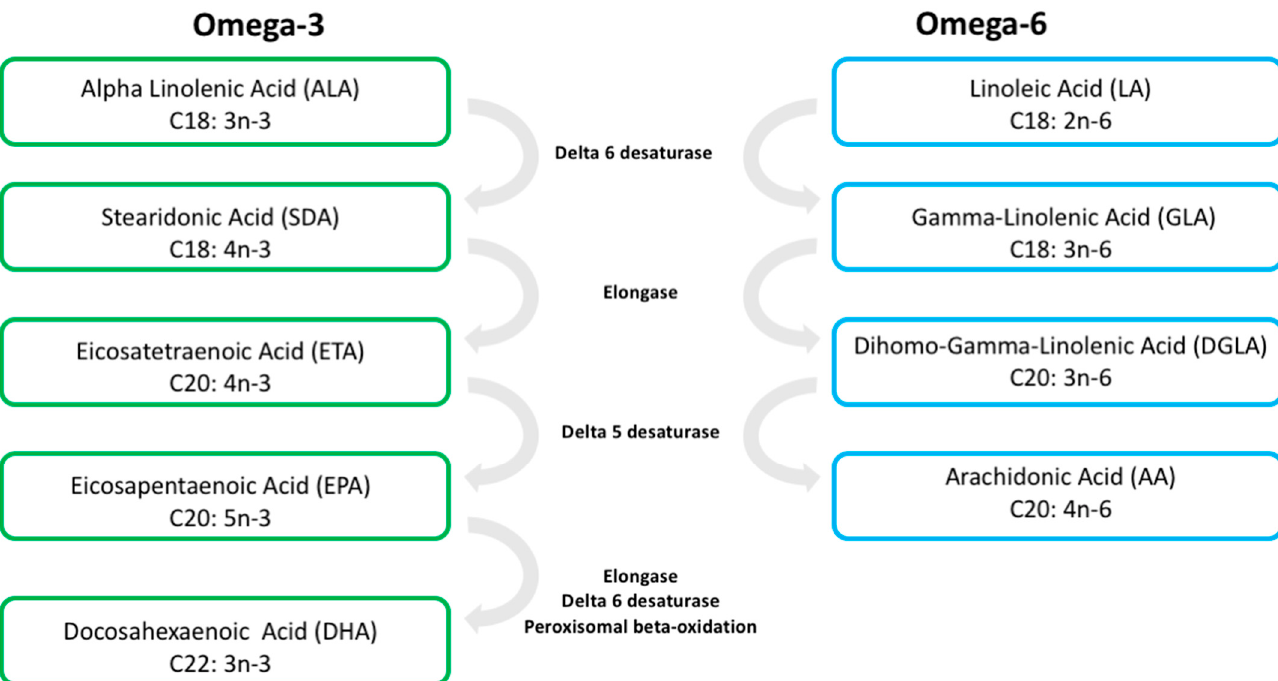
Figure 1. The formation of long-chain polyunsaturated fatty acids involve the addition of double bonds by Delta 5 and Delta 6 desaturase and the elongation of the carbon chain by Elongase. Arachidonic acid (AA), Eicosapentaenoic acid (EPA), and Docosahexaenoic acid (DHA) are synthesized by a stepwise process that starts with the desaturation of the 18-carbon essential fatty acids Alpha Linolenic Acid (ALA) and Linoleic Acid (LA). Delta-5 and -6 desaturases are rate-limiting enzymes; thus, there is a competitive relationship between ALA and LA in the formation of AA, EPA, and DHA.